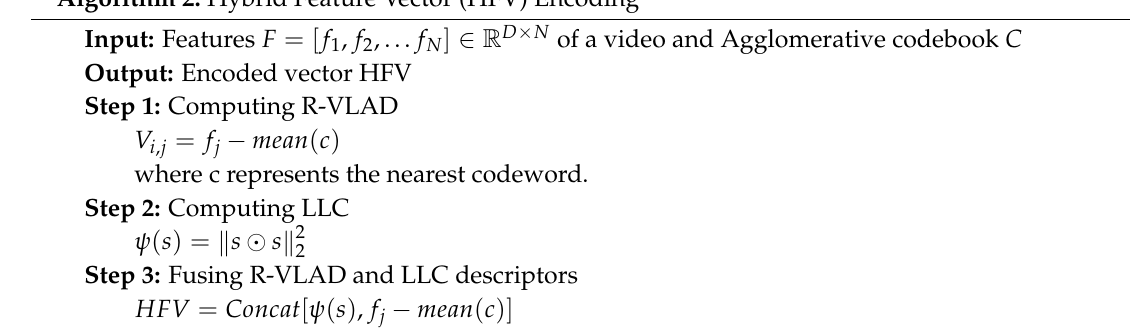
Algorithm 2: Hybrid Feature Vector (HFV)